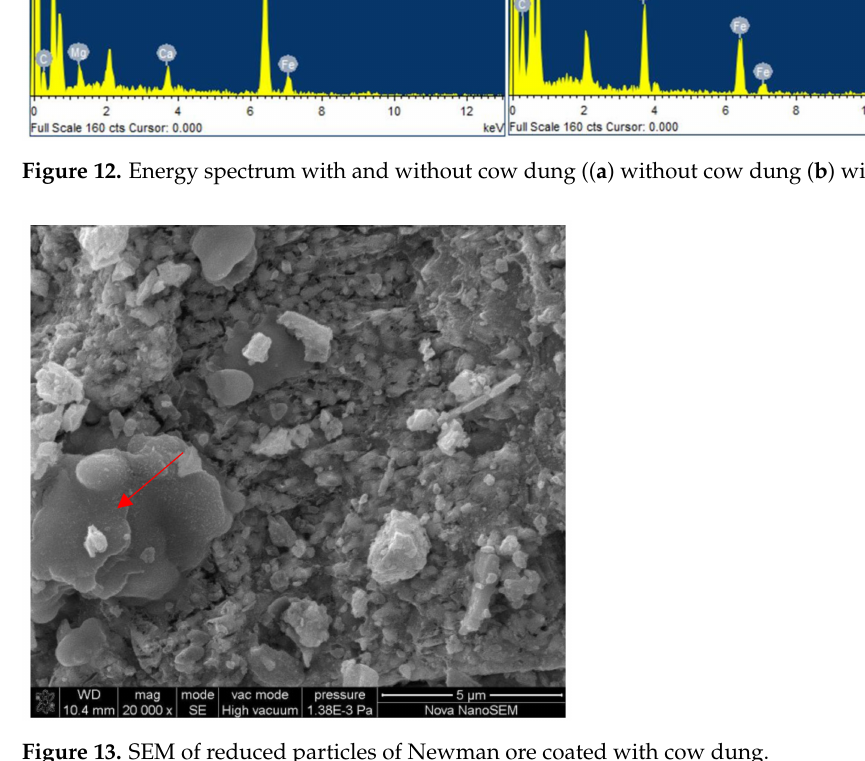
Figure 13. SEM of reduced particles of Newman ore coated with cow